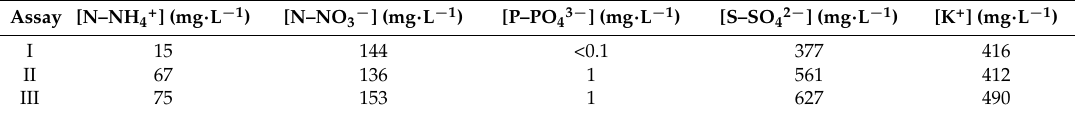
Table 4. Chemical composition of the different landfill leachates used in the assays I, II and